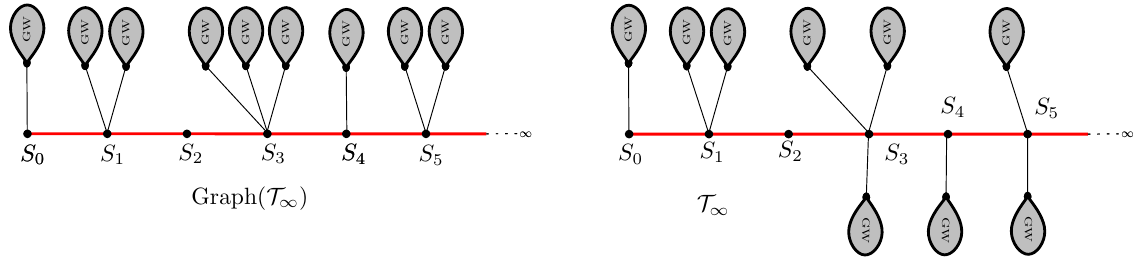
Figure 2: The construction of T from a spine and a random ν − 1 number of ν -Galton–Watson trees ∞ grafted on each vertex. After assigning an order to the children of each vertex of the spine we obtain the plane tree T ∞